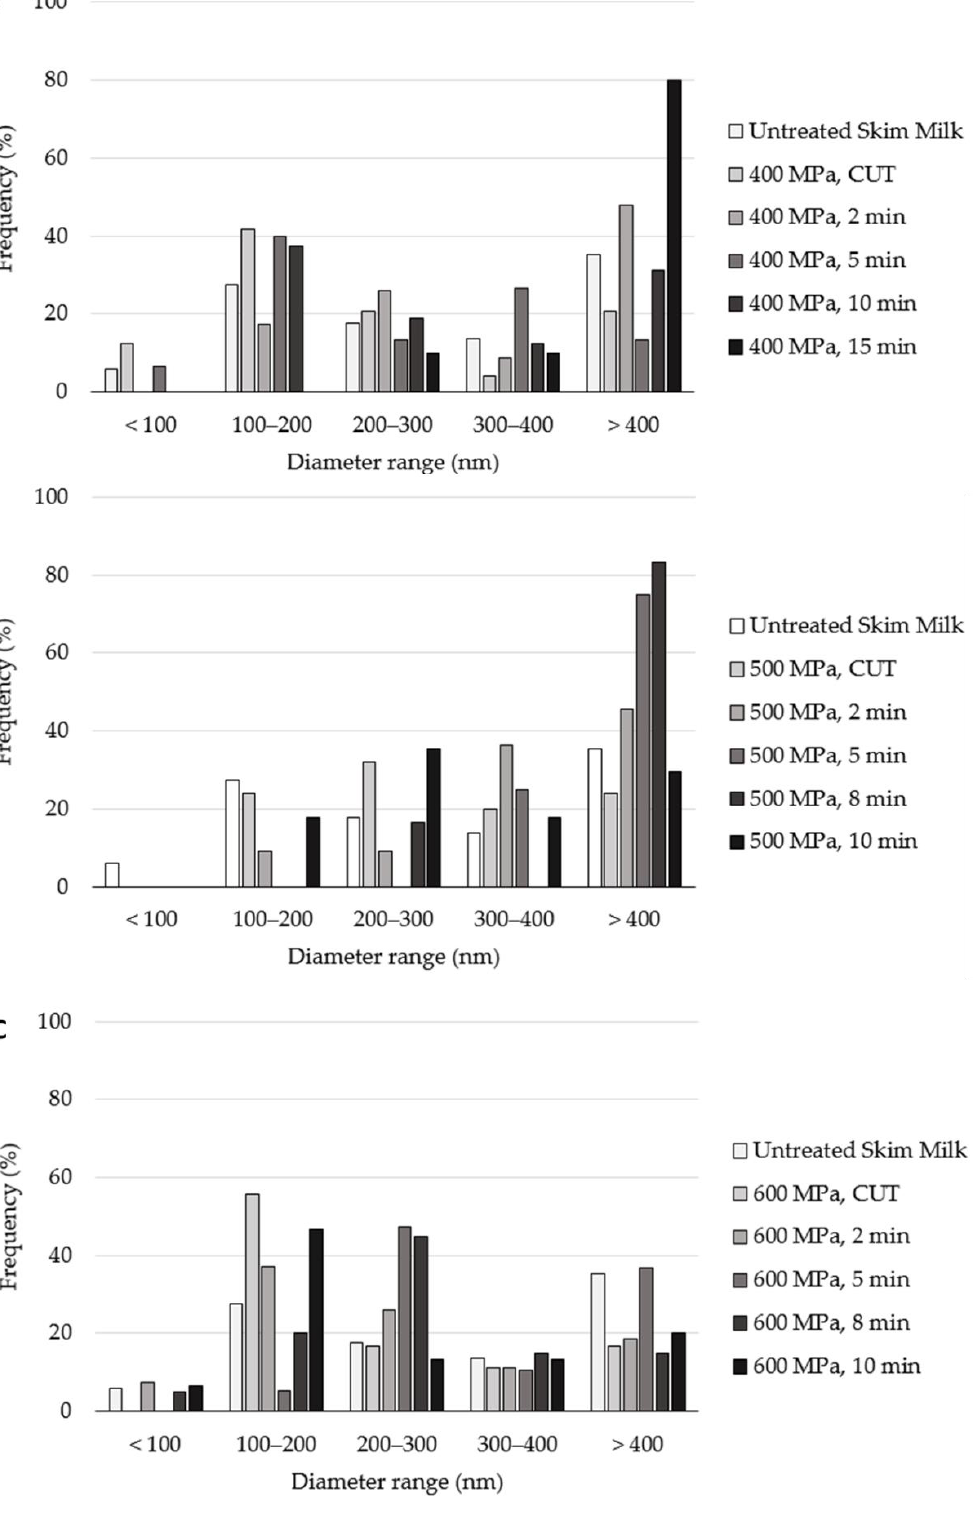
Figure 8. Casein micelle diameter distribution in 400 ( A ), 500 ( B ) and 600 MPa ( C ) high-pressure- treated homogenized, skim milk samples. The measurements were recorded from the micrographs by the scanning electron microscopy equipment software.